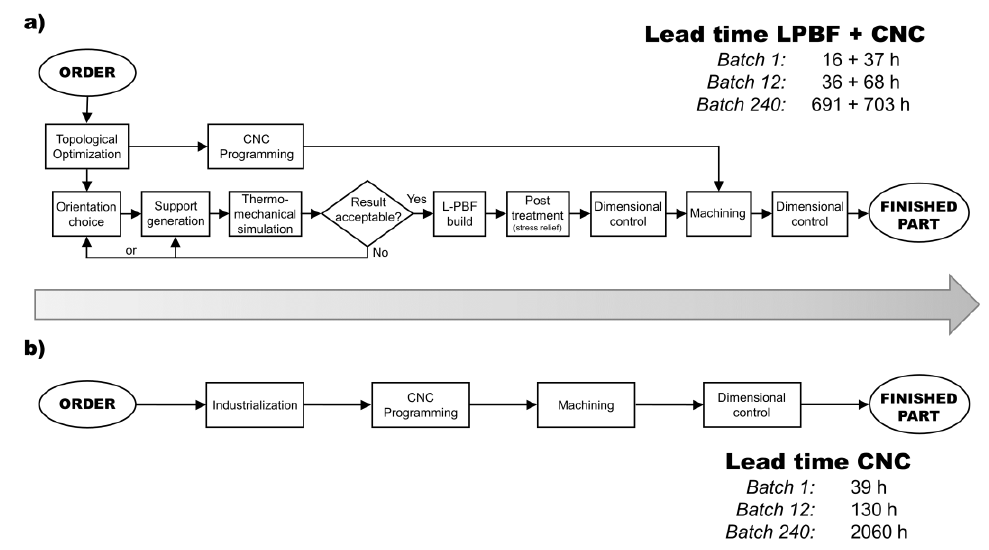
Figure 4. Comparison of workflow and lead-time for different volume batches for LPBF + CNC ( a ) and for CNC alone ( b ).